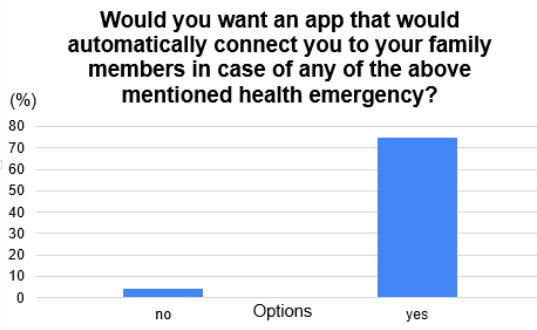
Fig. 4. Survey results for question 2